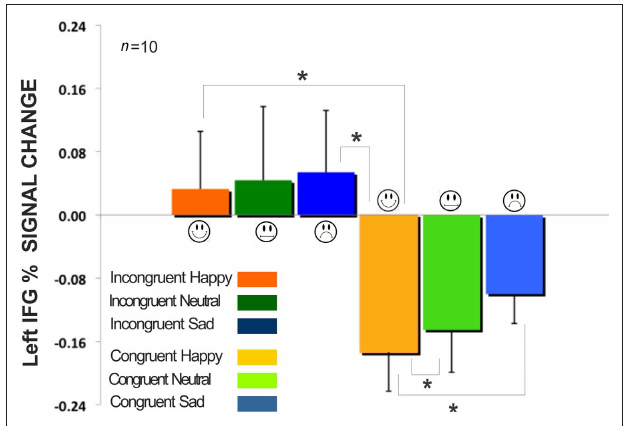
FIguRe 6 | Comparison of incongruent and congruent expressions in the Word instruction condition for the left inferior frontal gyrus in Figure 5F. All fixation volumes were used as the baseline. Error bars signify the standard error of mean (SEM). Incongruent expressions (Happy, Neutral, Sad) showed significantly larger BOLD signal change compared to congruent expressions. (*signifies p <